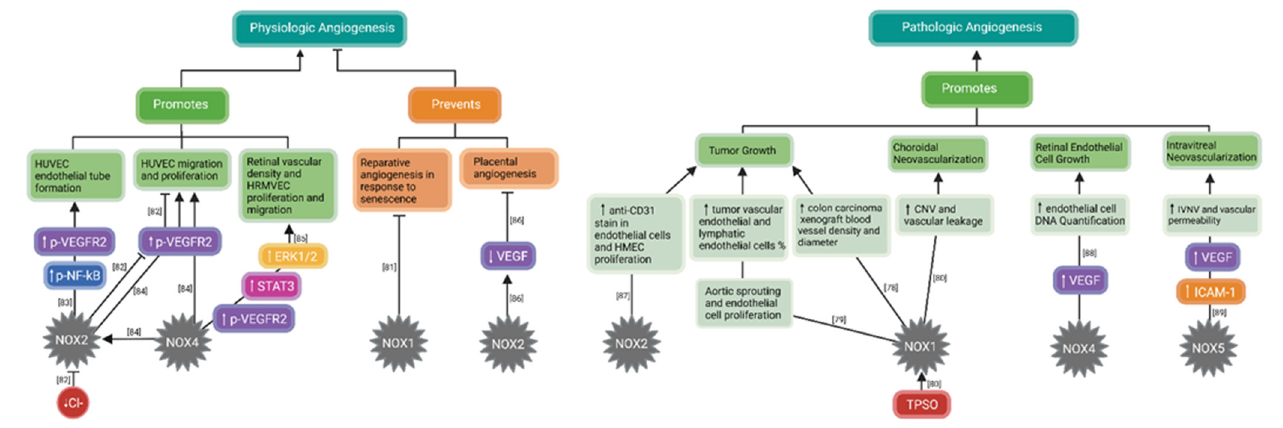
Figure 2. Role of nicotinamide adenine dinucleotide phosphate (NADPH) oxidase (NOX) in physi- ologic and pathologic angiogenesis. Reduced chloride (Cl − ) concentration inhibits NOX2 assembly to the active enzyme, resulting in reduced VEGFR2 signaling in HUVEC and decreased cell migra- tion and proliferation [82]. NOX2-generated ROS promote physiologic angiogenesis in HUVEC cells through activation of nuclear factor kappa B (NF-kB) and vascular endothelial growth factor recep- tor 2 (VEGFR2) [83]. NOX4-generated ROS influence NOX2 activity, and both NOX2 and NOX4- generated ROS increase activation of VEGFR2, resulting in HUVEC migration and proliferation [84]. NOX4 is involved in VEGF-mediated activation of VEGFR2 and downstream signaling of STAT3 and ERK1/2 to promote physiologic vascularization in the retina [85]. NOX1-generated ROS prevent reparative angiogenesis in response to senescence [81], and NOX2-generated ROS downregulate STAT3-dependent VEGF expression and prevent placental angiogenesis [86]. Regarding pathologic angiogenesis, NOX1- and NOX2-generated ROS contribute to tumor growth [78,79,87]. Translocator protein (TPSO) is necessary for NOX1-mediated ROS generation [80], which promotes choroidal neovascularization (CNV) and vascular leakage in a model of age-related macular degeneration [80]. NOX4-generated ROS promote retinal endothelial cell growth in response to oxidative stress [88] and NOX5-generated ROS increase IVNV [89]. Studies are cited in brackets according to their reference number ( ┴ : inhibit; → : promote). Created with Biorender.com. NOX4 is the predominant NOX in human retinal endothelial cells (HREC) [90],